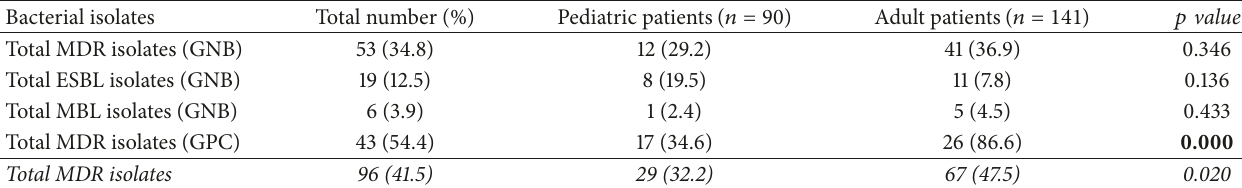
Table 6: Trends of multidrug resistance of bacterial isolates among pediatric and adult patients ( 𝑛 = 231 ). Bacterial isolates